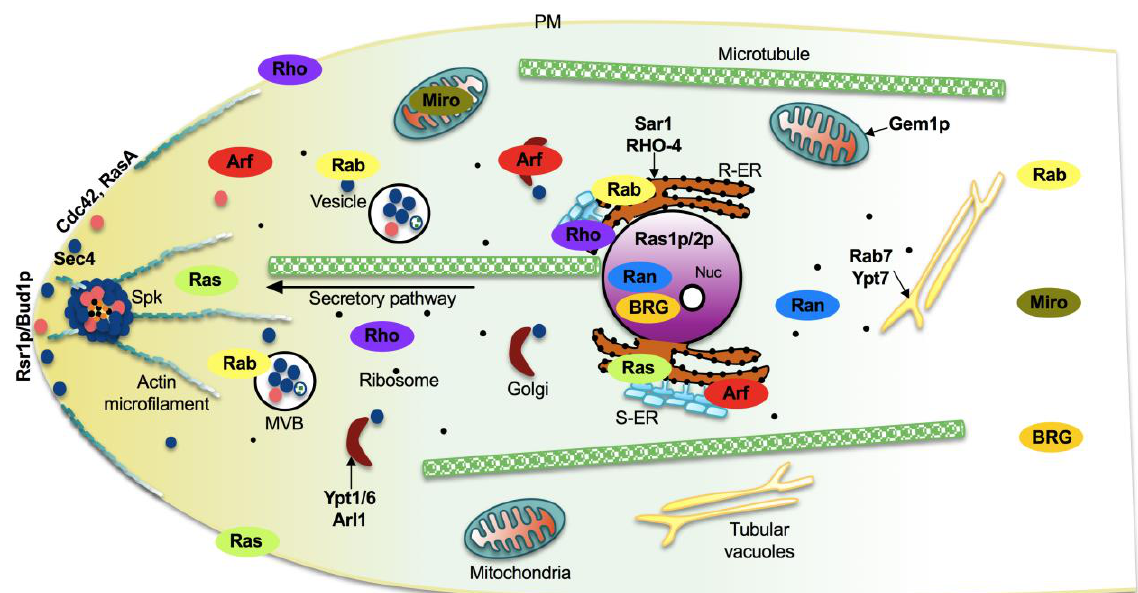
Figure 7. Subcellular localization of Ras, Rho, Rab, Ran, Arf, Miro, and BRG GTPases. The localization of each GTPase depends mainly on its activity. Ras (green ovals) and Rho (purple ovals) proteins are primarily found at ER, cytoplasm, and PM; Rab (light yellow ovals) at ER, vesicles, MVB, or endosomes; Ran (blue ovals) at nucleus and cytoplasm; Arf (red ovals) at ER, Golgi, and cytoplasm; Miro (olive green ovals) at mito-chondria, and BRG (dark yellow ovals) are predicted to be found mainly in the nucleus. Rab, Miro, and BRG could be present at the cytoplasm as well but to a lesser extent. Some examples of specific small Ras GTPases are shown (i.e., Ras, Rsr1p/Bud1p, RasA, Ras1p/2p; Rho, Cdc42, RHO-4; Rab, Sec4, Rab7, Ypt1/6, Ypt7; Arf, Sar1, Arl1; Miro, Gem1p). This figure was drawn according to the literature discussed here as well as by predicting their subcellular localization using WoLF PSORT [57] and COMPARTMENTS [58] programs. The names of each organelle are indicated. Spk: Spitzenkörper; S-ER, R-ER: smooth and rough endoplasmic reticulum; PM: plasma membrane; Nuc: